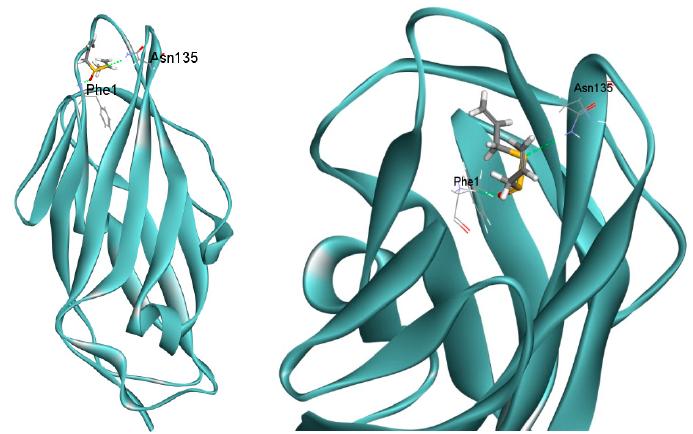
Figure 7. Binding mode of allicin in the FimH lectin domain crystal structure (4BUQ) in complex with heptyl α - D -mannopyrannoside and their main interactions. Allicin was docked into the FimH crystal structure in complex with heptyl α - D -mannopyrannoside (4BUQ). The first pose of 10 docking runs is represented in sticks, with interacting side chains represented by lines.